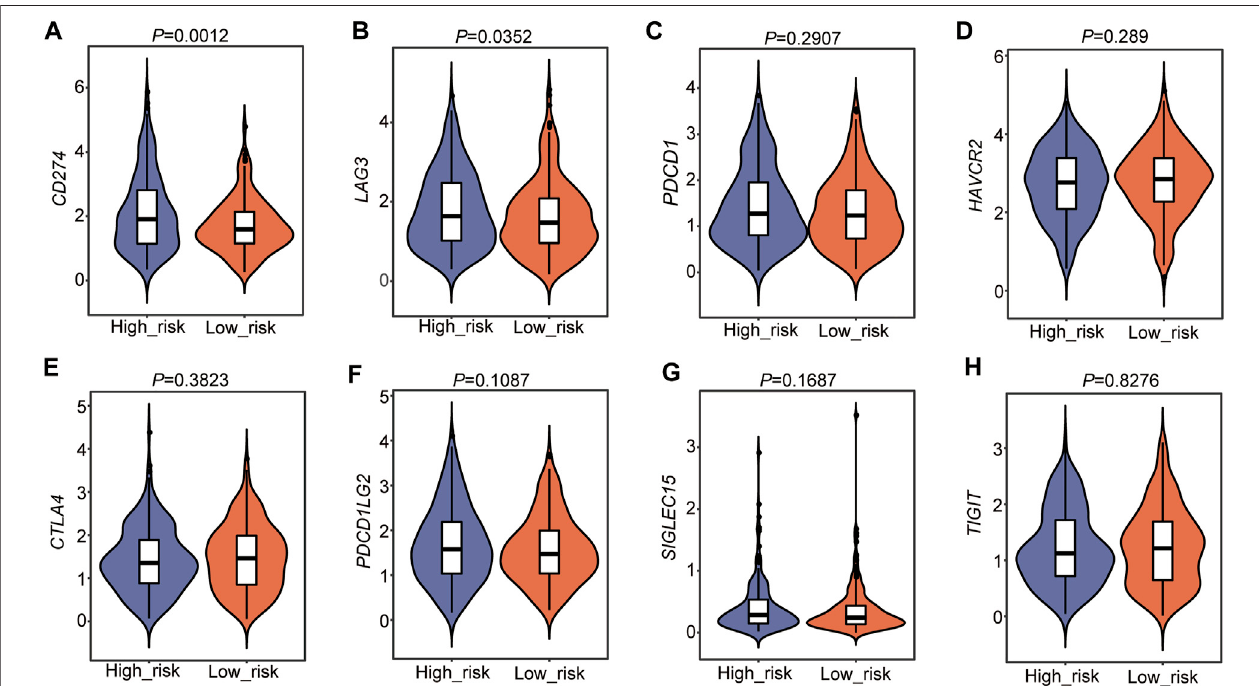
FIGURE 9 | Immune checkpointgene analysis in the two risk subtypes. (A – H) Immune checkpoint gene analysis in the two risk groups. The statistical signi fi cance was calculated via the Wilcoxon rank-sum test.